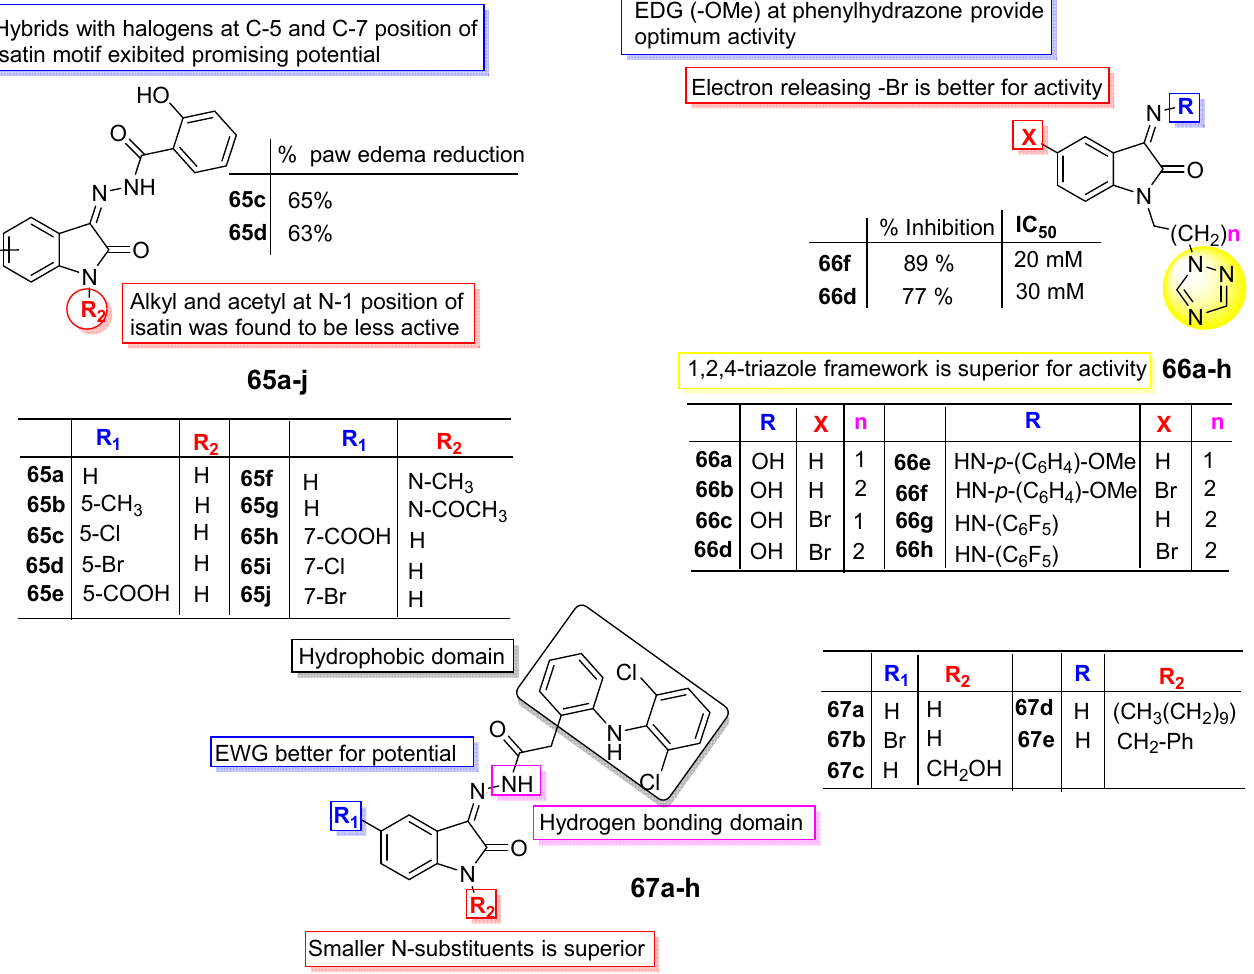
Figure 8. SAR features of isatin and its derivatives required for potent anti-inflammatory